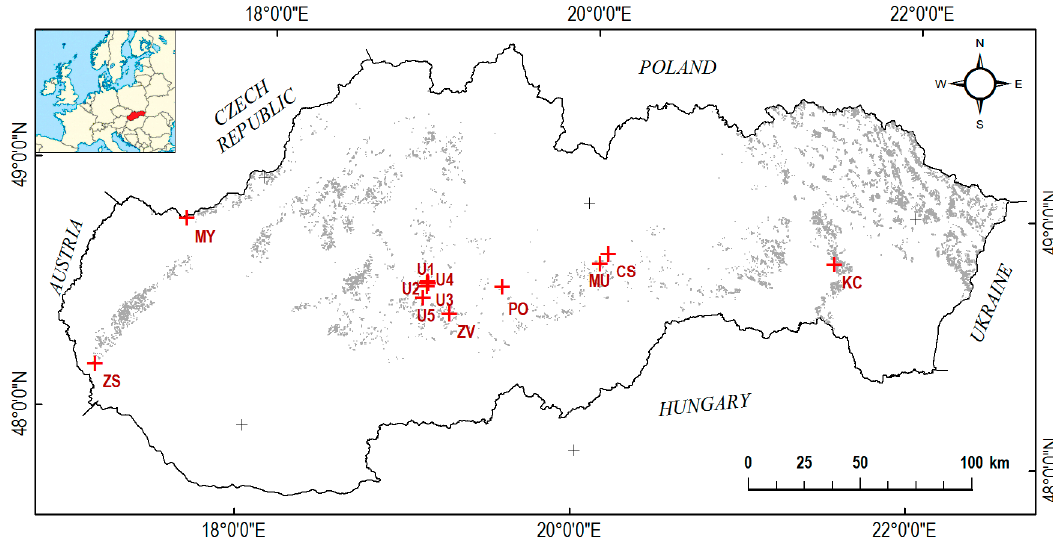
Figure 1. Map of the beech stands with the presence of European beech at 60% and higher (grey color). The locations of the study stands with in situ phenological observations are marked with red crosses.